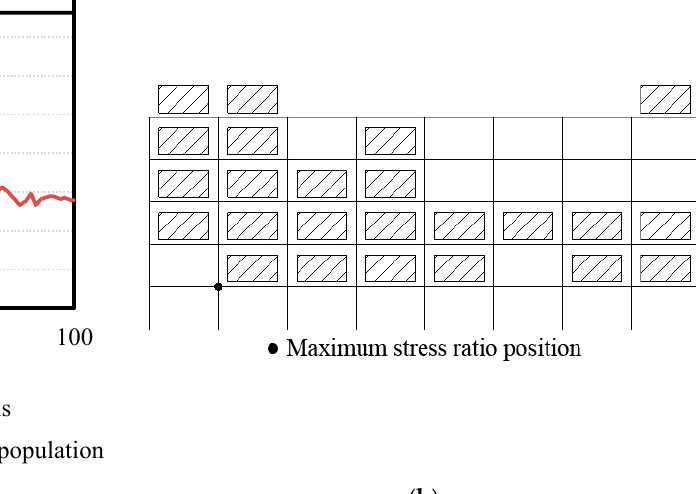
Figure 14. The most unfavorable distribution of load under 60% full load. ( a ) Tracking chart of optimization performance of GA. ( b ) The most unfavorable distribution of load (H = 2.54, P = − 0.79).